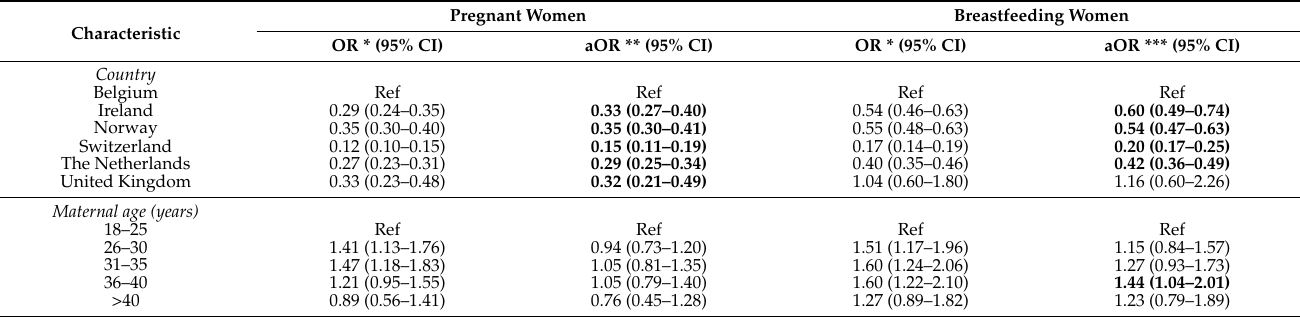
Table 3. Factors related to COVID-19 vaccine willingness among pregnant and breastfeeding